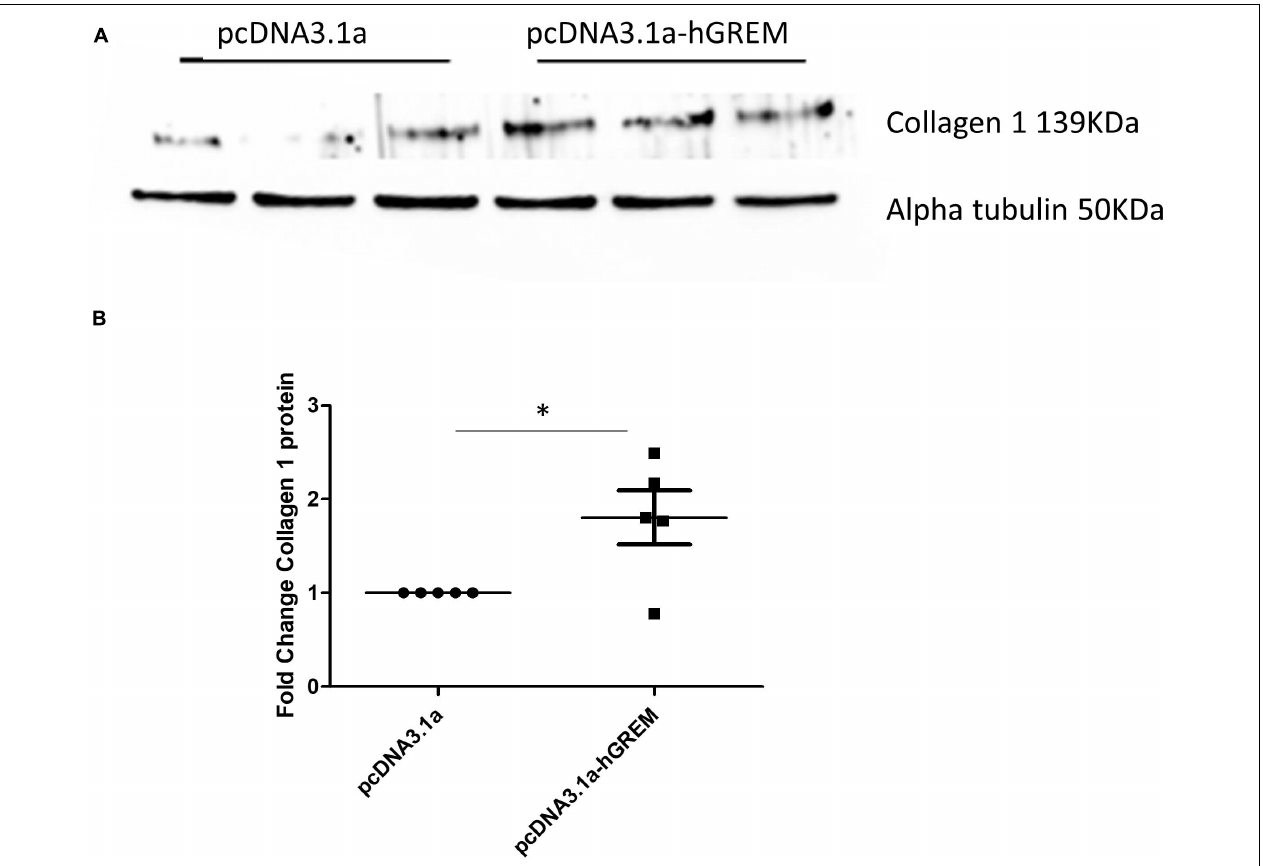
FIGURE 2 | Gremlin-1 overexpression conditioned medium increased collagen expression. (A) Normal human dermal fibroblasts were transfected with plasmid pCDNA3.1a with or without the insert for human Gremlin-1, after 48 h the media was removed and then placed onto new dermal fibroblasts after a further 48 h cells were lysed and subjected to western blotting for the specified proteins. (B) Densitometric analysis of collagen after plasmid transfection data is normalized to alpha tubulin expression and shown as fold change compared to pcDNA3.1a ( n = 5). The meaning of ‘*’ is significantly different students t